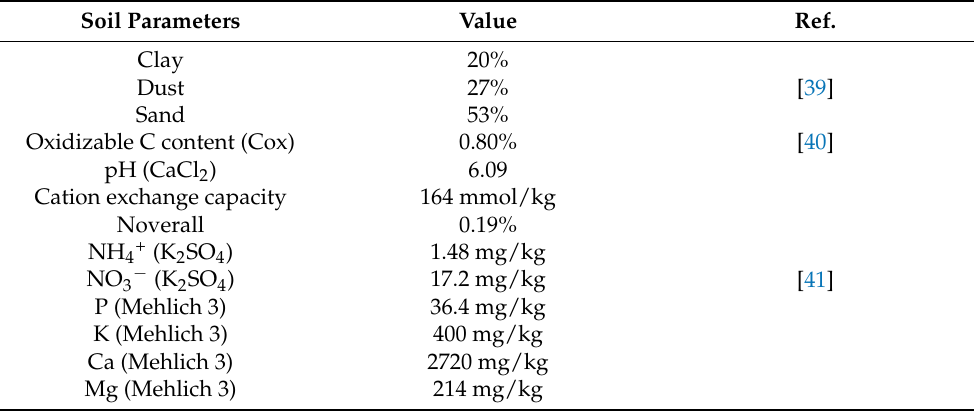
Table 1. Agrochemical properties of used soil in the pot experiment.